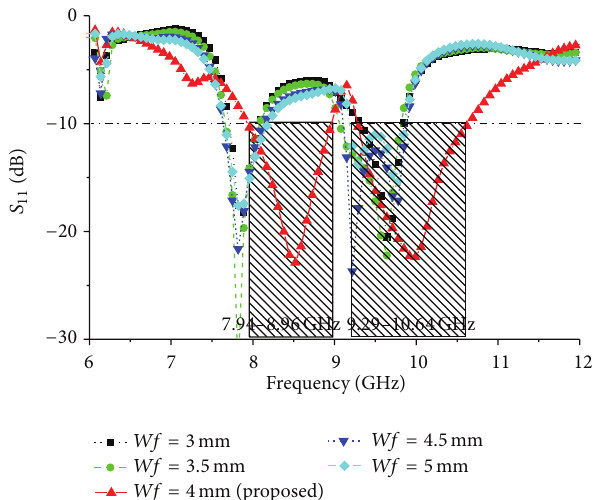
Figure7:Simulatedreturnlossforthemicrostripfeedlinepositions 𝑋𝑓 and 𝑌𝑓 .